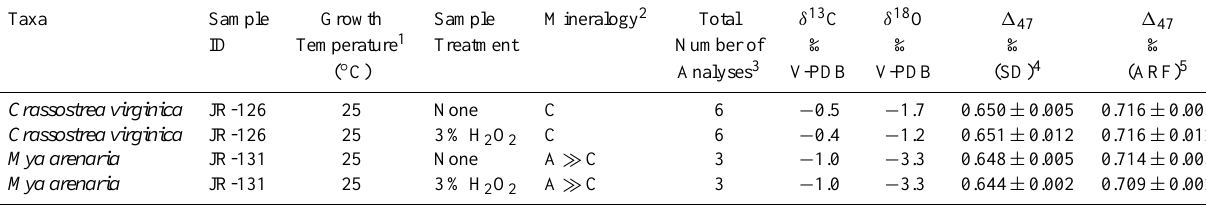
Table 1. Effect of oxidative sample cleaning on mollusk stable isotope data.